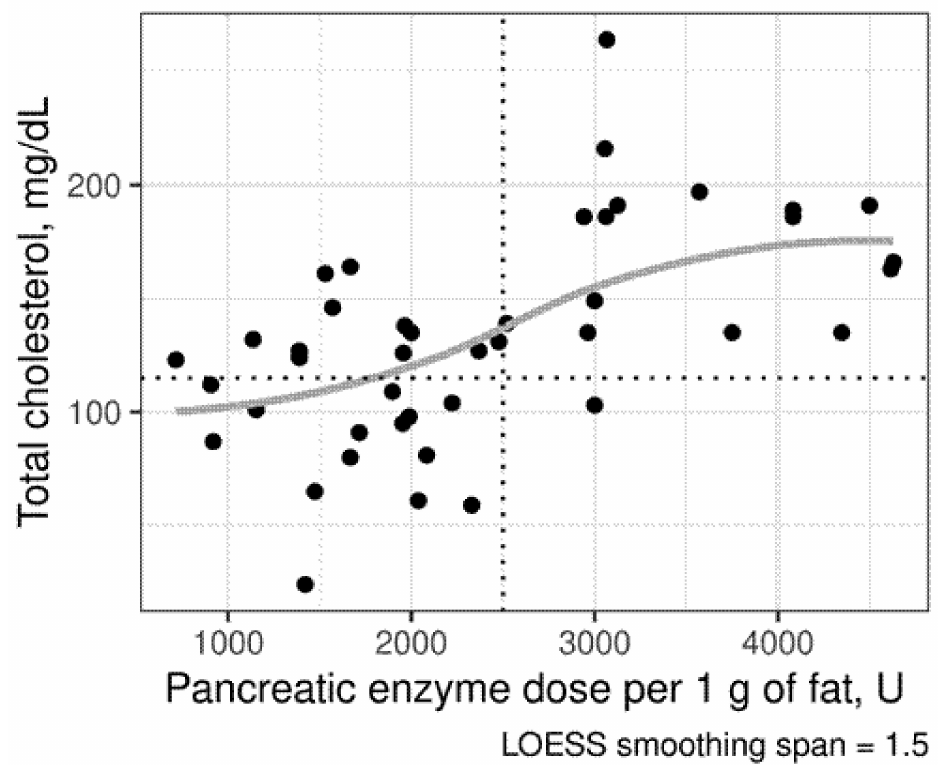
Figure 5. Scatterplot of total cholesterol in pancreatic-insufficient (PI) patients with cystic fibrosis (CF) with different doses of pancreatic enzymes. Points below the dotted horizontal line indicate patients with hypocholesterolemia as defined by the local laboratory reference range (< 115 mg/dL or 3 mmol/L). The vertical line was set at the enzyme dose of 2750 lipase units/g of fat, above which only one patient experienced hypocholesterolemia. The lower rate of hypocholesterolemia in PI CF patients receiving >2500 U/d of pancreatic enzyme replacement therapy was confirmed by Fisher’s test (two-sided p = 0.0026). Locally estimated scatterplot smoothing (LOWESS) curve is displayed in